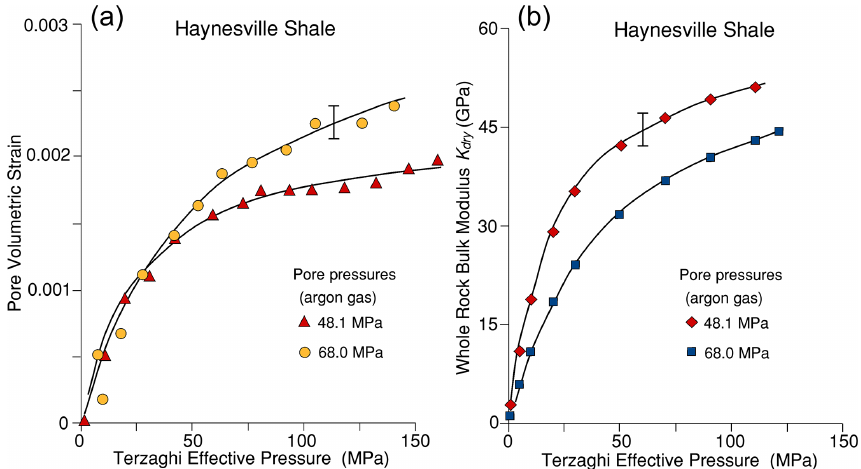
Figure 8. (a) Pore volumetric strain (as fraction of total specimen volume) vs. Terzaghi effective pressure for Haynesville shale at the pore pressures indicated. Pore volume loss is approx. only 2% of the initial pore volume of the rock. Logarithmic fits to two of the data sets are shown. (b) The gradients of the fitted lines in (a) correspond to the pore compressibility and were used to obtain K dry vs. P eff , as shown in (b) for the two pore pressures used. K o =